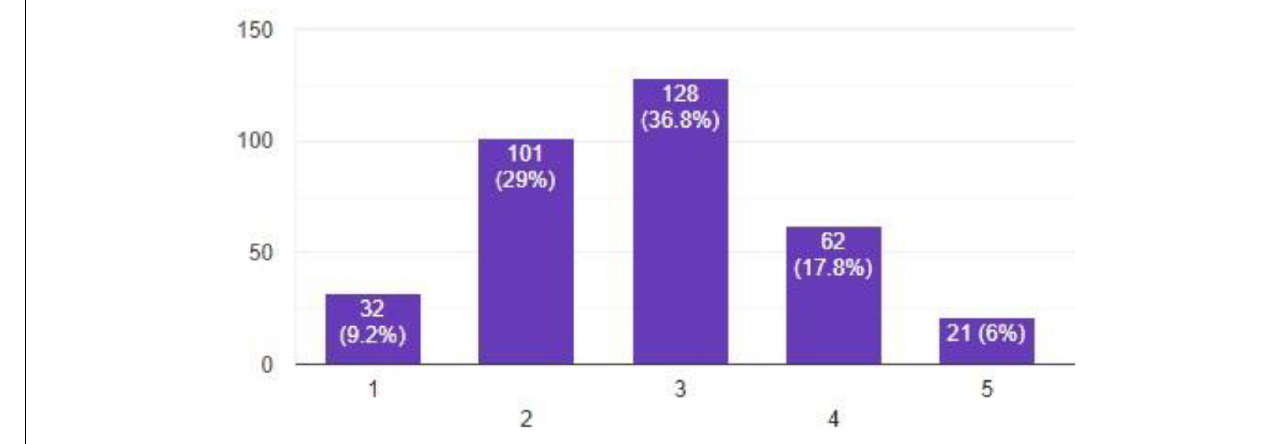
FIGURE 1 | Change in electricity and gas bills.